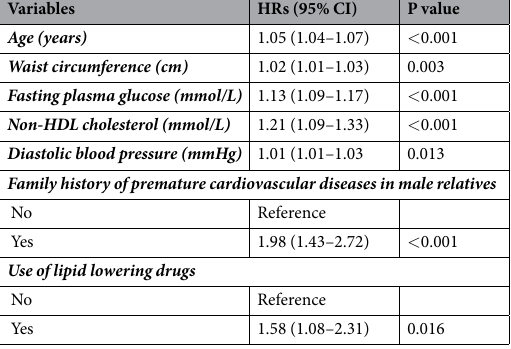
Table 5. Multivariate Cox regression analysis of factors associated with CHD incidence in female population (n = 3,403), Tehran Lipid and Glucose Study (1999–2012). Cox proportional hazard regression model with stepwise selection method was used to calculate hazard ratios (HRs) and 95% confidence interval (CI), and Akaike information criteria (AIC) was used for model selection approach.